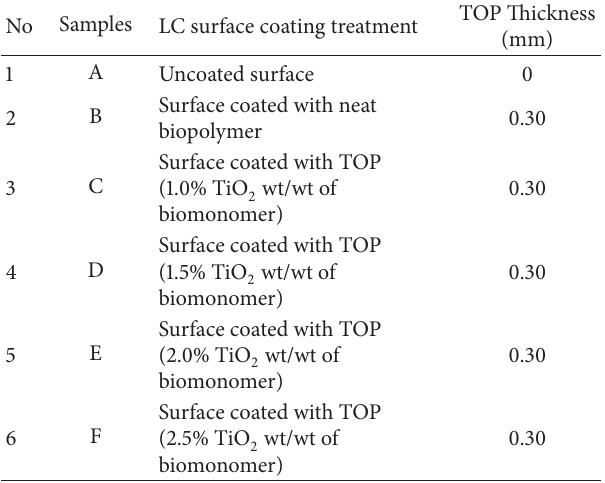
Table 2: Fabrication of LC coated with TOP for all test